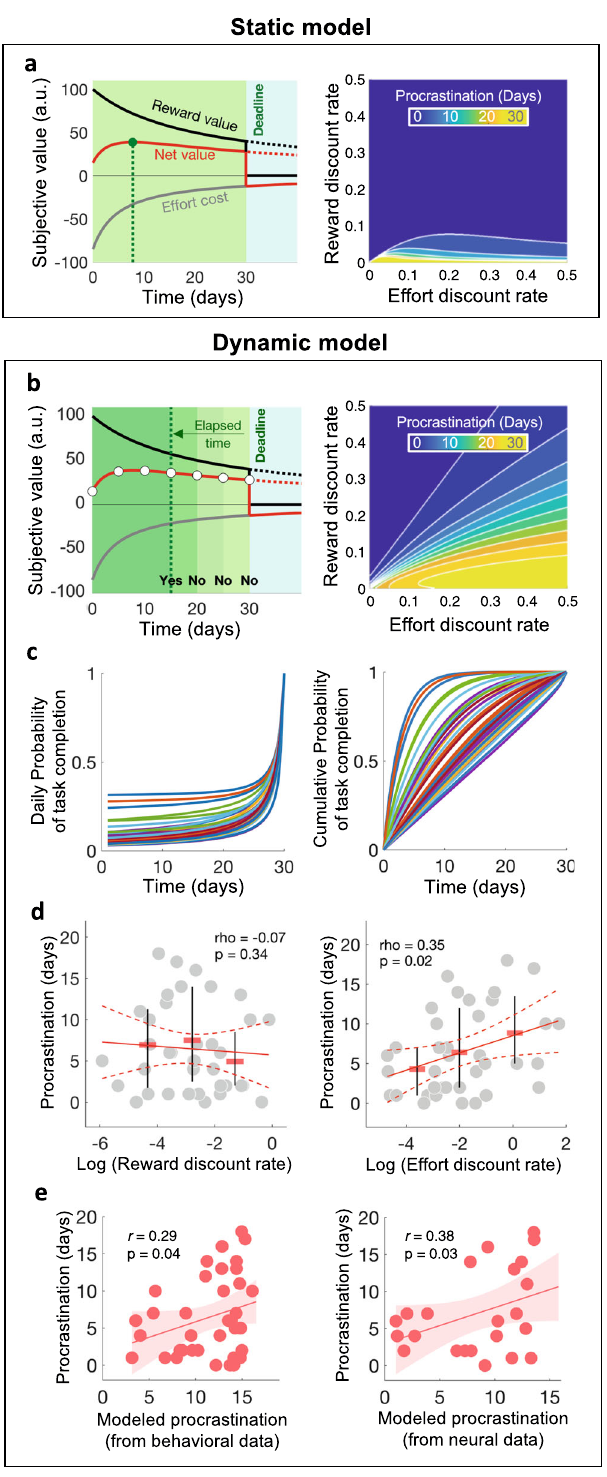
Fig. 6 | From static to dynamic computational model of procrastination. a Static model. Effort cost and reward value are both discounted with time, and reward value vanishes after the deadline. The predicted delay for task completion (i.e., procrastination duration) is the one that maximizes the net value function (green dot). Simulations of procrastination duration under the static model shows thatit mostly occurswithlow temporal discount rates, even lower for reward than for effort b Dynamic model. Everyday, the net value of completing the task now is compared to all other remaining available dates (white dots) through a softmax function that provides choice probabilities. As time goes by and the deadline gets closer, the comparison includes fewer dates, which increases the probability of performing the task. This probability obtained for each day is added to the prob- ability of having completed the task on every past day, to generate a cumulative probability.Thepredicteddelayoftaskcompletionistheexpectedvalueunderthis cumulative distribution. Simulations of procrastination duration under the dynamic model shows that it occurs with a wide range of temporal discount rates, provided that they are lower for reward than for effort. c Daily and cumulative probability of task completion across time, under the dynamic model. Each curve represents one participant. d Observed procrastination duration plotted against temporaldiscountratesforreward( k R )andeffort( k E ).Eachdotisaparticipant.Red barsrepresentthe means, and whiskersthe 25thand 75thpercentiles,inthree bins ofequalsize. e Inter-participantone-tailedPearson ’ scorrelationbetweenobserved and modeled procrastination duration, under the dynamic model, based on behavioral data or neural data. Each dot is a participant. The number of dots cor- responds to the number of participants who did send back the completed forms ( n =37 for behavioral data and n =23 for fMRI data). Source data are provided as a Source Data fi